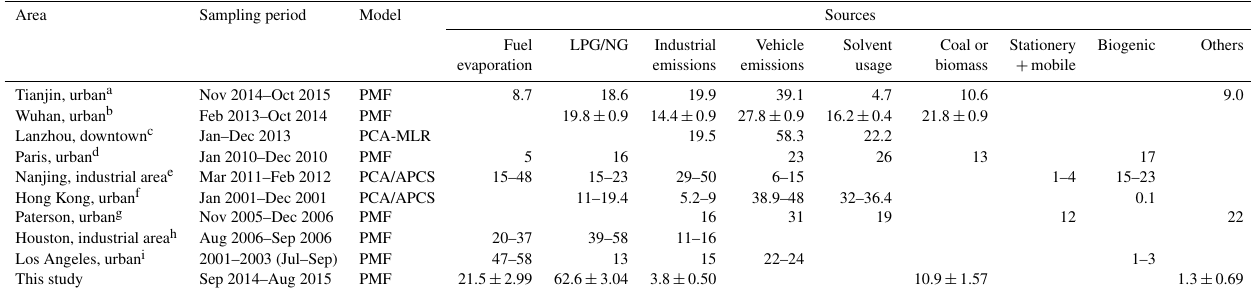
Table 2. Comparison of VOC source apportionment results with former studies. Area Sampling period Model Sources Fuel LPG/NG Industrial Vehicle Solvent Coal or Stationery Biogenic Others evaporation emissions emissions usage biomass + mobile Tianjin, urban a